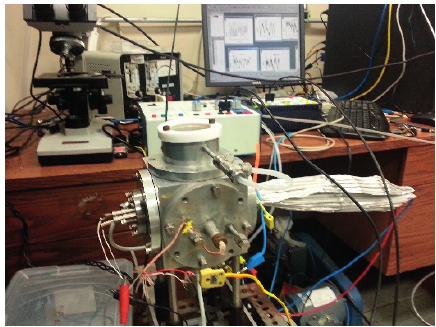
Figure 4. Photograph of experimental set up for characterization of newly fabricated gas